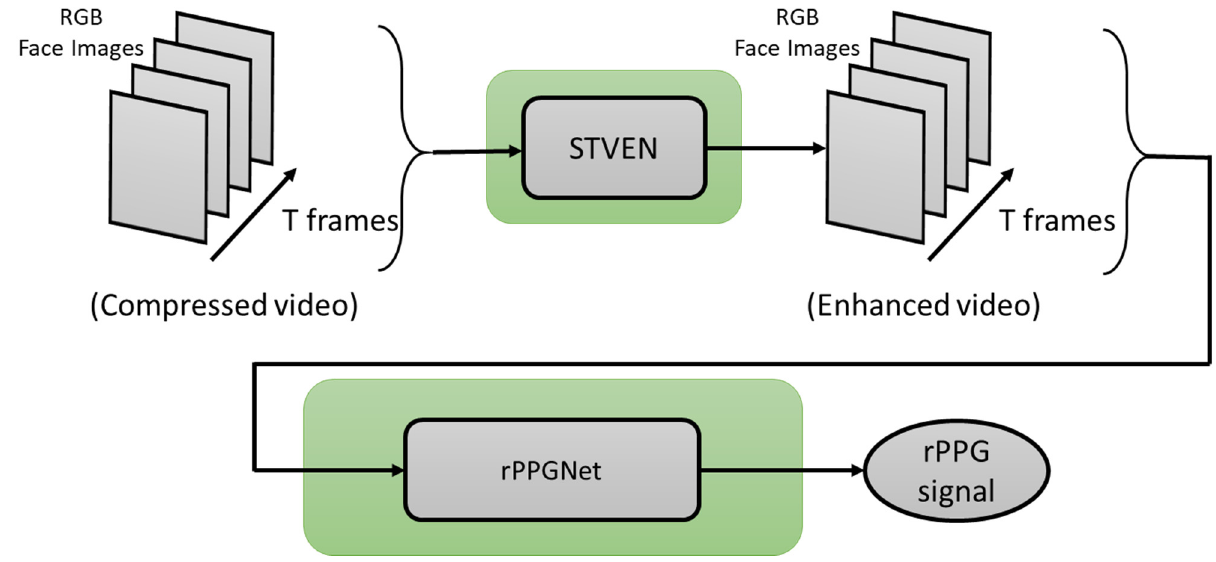
Figure 10. Architecture of STVEN-rPPGNet.